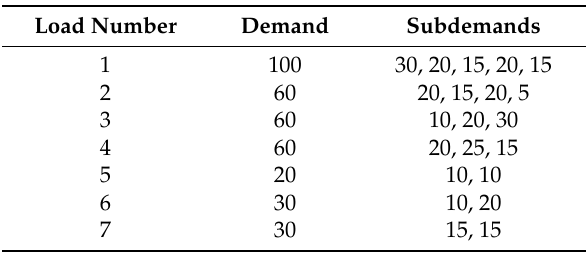
Figure 3. Implemented system in a distributed environment. ( a ) Test environment of our laboratory; and ( b ) operational process on the implemented system. Table 2. Details of load data for modified Consortium for Electric Reliability Technology Solutions (CERTS) MG.